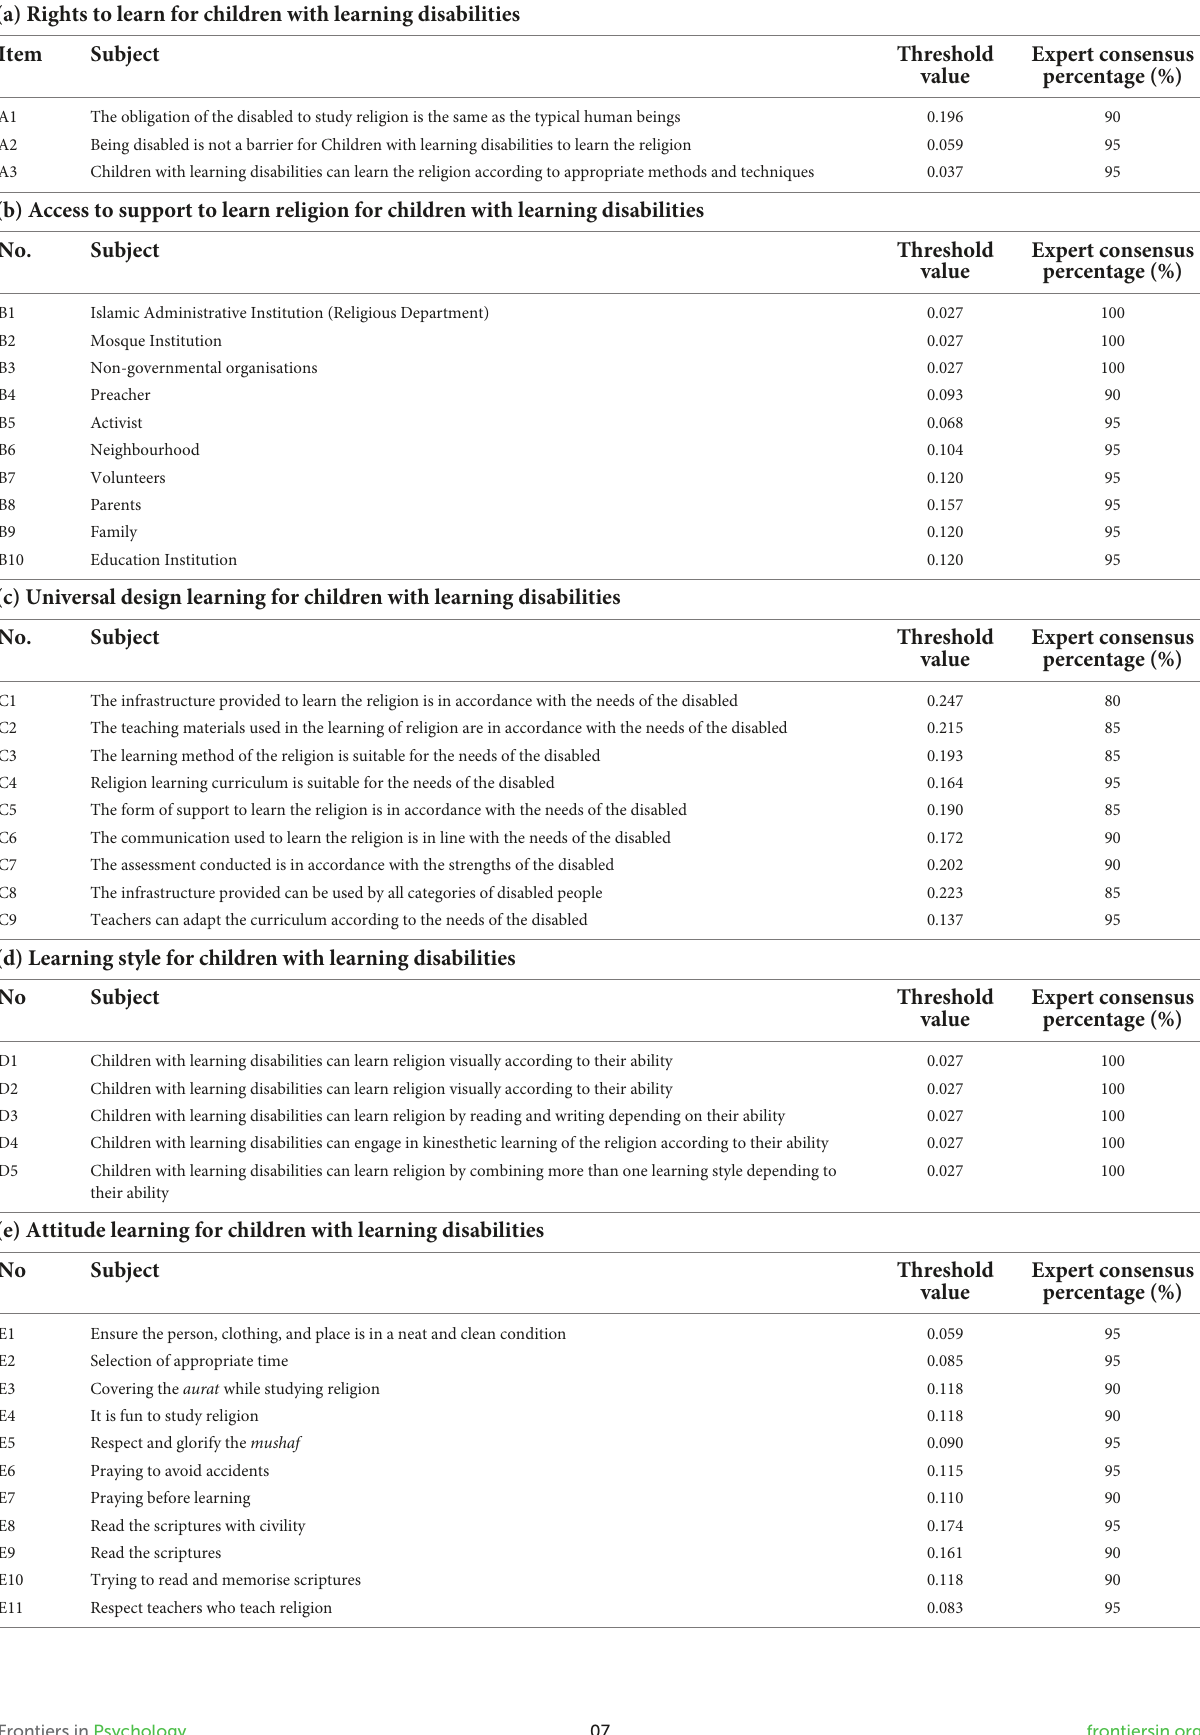
TABLE 4 Findings of threshold values of the content religious education learning for children with learning